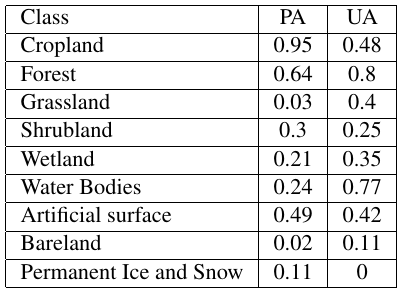
Table 5. Per-class accuracy indexes for Europe